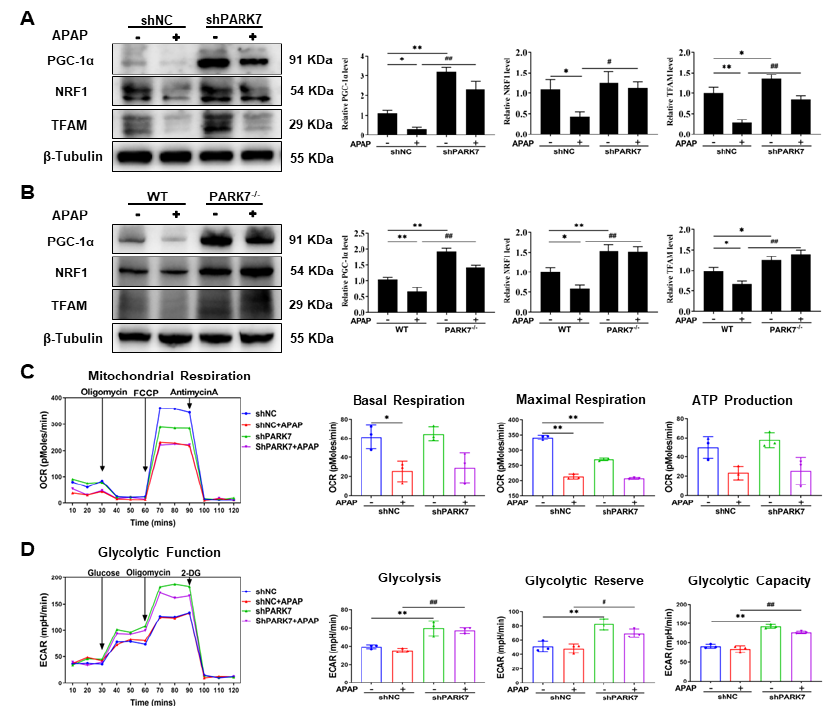
Figure 6. Changes in mitochondrial-related indexes after PARK7 silencing. ( A ) Changes in mitochondrial synthesis proteins in APAP-treated L02 cells with and without PARK7 silencing and statistical analysis, N = 3. * p < 0.05 vs. ShNC group, ** p < 0.01 vs. ShNC group, # p < 0.05 vs. ShNC+APAP group, ## p < 0.01 vs. ShNC+APAP group. ( B ) WB and statistical analysis of the mitochondrial synthetic proteins PGC-1 α , NRF1 and TFAM in the liver tissue of mice with or without APAP intervention with PARK7 knockdown, N = 3, * p < 0.05 vs. WT group, ** p < 0.01 vs. WT group, ## p < 0.01 vs. WT+APAP group. ( C , D ) Changes in mitochondrial respiratory function and glycolytic function under APAP intervention with or without PARK7 silencing, N = 3. * p < 0.05 vs. shNC group, ** p < 0.01 vs. shNC group, # p < 0.05 vs. shNC+APAP group, ## p < 0.01 vs. shNC+APAP